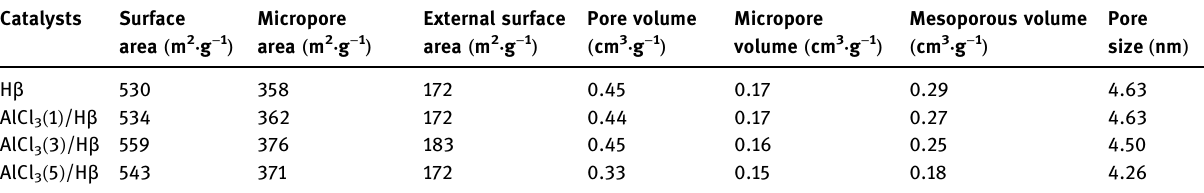
Table 2: BET characterization results of AlCl 3 /H β catalysts prepared with di ff erent concentrations of AlCl 3 Catalysts